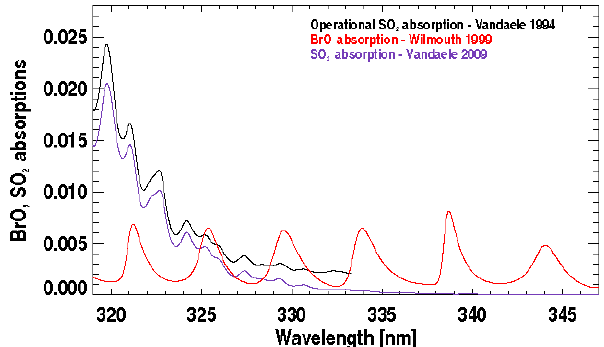
Figure 12. Comparison of BrO absorption (red) and SO 2 absorp- tions under volcanic scenarios based on cross sections used in the operational algorithm (Vandaele et al., 1994) as shown in black and the recent laboratory cross sections (Vandaele et al., 2009) as shown in purple. For BrO, a SCD of 1 . 0 × 10 14 moleculescm − 2 is assumed; for SO 2 , a SCD of 15 Dobson units (i.e., 4 . 03 × 10 17 moleculescm − 2 ) is assumed. Cross sections have been con- volved with the OMI slit function (which is assumed to be a Gaus- sian with 0.42nm full width at half